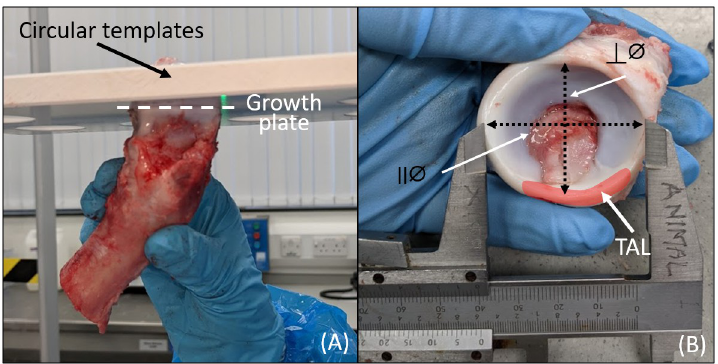
Fig 3. Preparation of porcine samples for experimental simulation. (A) Measurement of femoral head diameter with the circular templates, diameter was recorded at parallel to the epiphyseal line (growth plate) whereby at this point the head easily fitted through a template of defined size. (B) Measurement of acetabular diameters taken parallel to the TAL (ll ; ); and perpendicular to TAL ( ?; ).